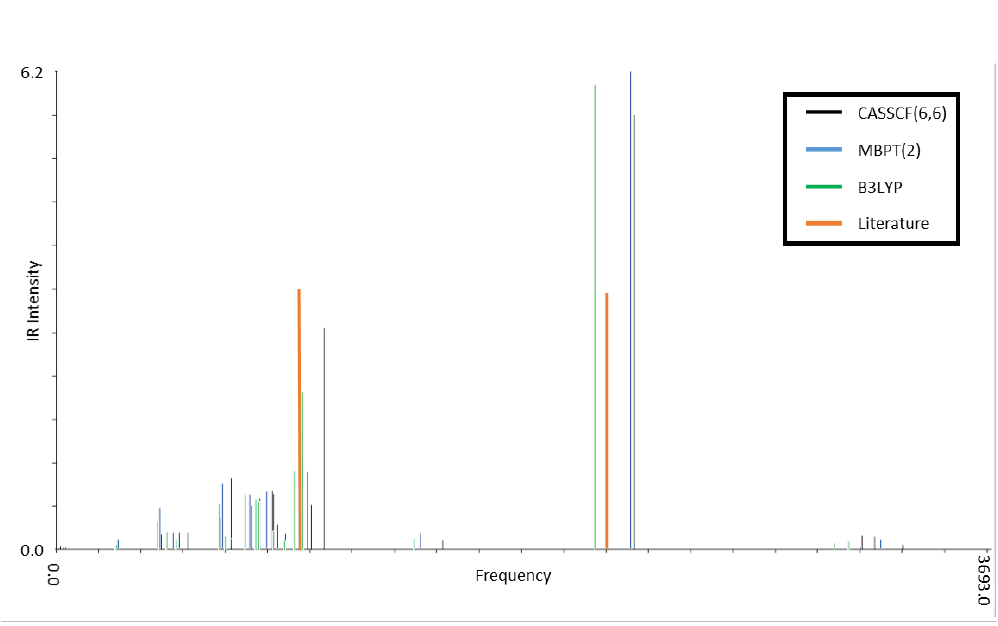
Figure 3. Simulated IR spectra for isomer 1 overlaid upon measured broad features from Reference [2] assigned arbitrary intensities. Frequencies are in cm − 1 and intensities have arbitrary units. Table 4. Vibrational frequencies (in cm − 1 ) as computed for isomers 1 and 2 at various levels of theory. Values for protonated species are reported above and deuterated species below. Intensities relative to the strongest band are provided in parentheses. Measured spectroscopic data are listed for